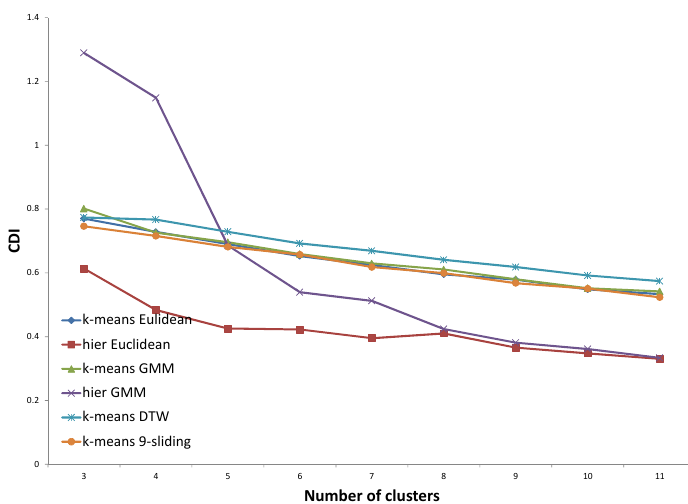
Figure 6. CDI result for the northern part of Gyeonggi Province.